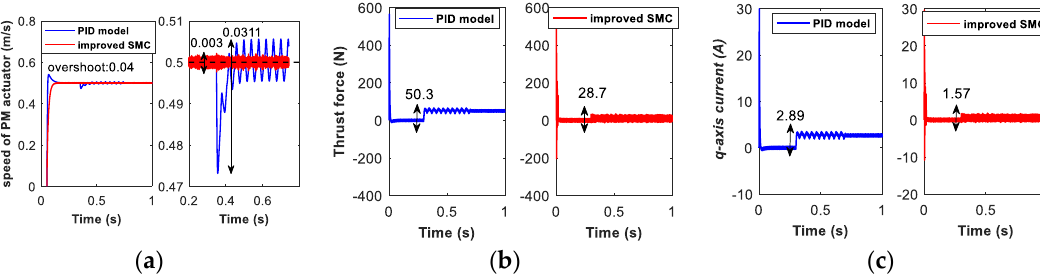
Figure 7. ( a ) Speed curves of segmented PMLSM with different models, ( b ) thrust forces of segmented PMLSM with different models and ( c ) q -axis currents of segmented PMLSM with different models.